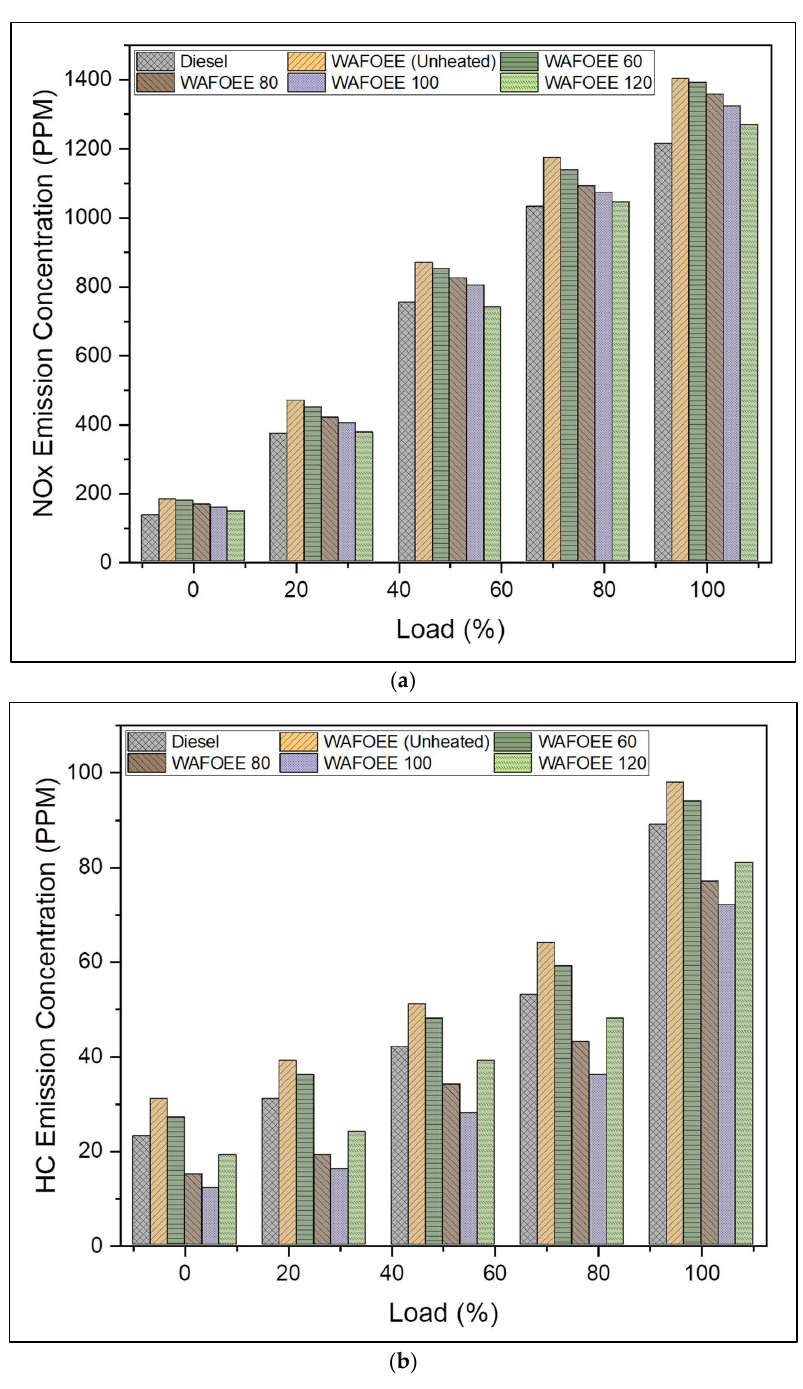
Figure 11. (a) NOX emissions of neat diesel and biodiesel samples for varying engine loads. (b) HC emissions of neat diesel and biodiesel samples for varying engine